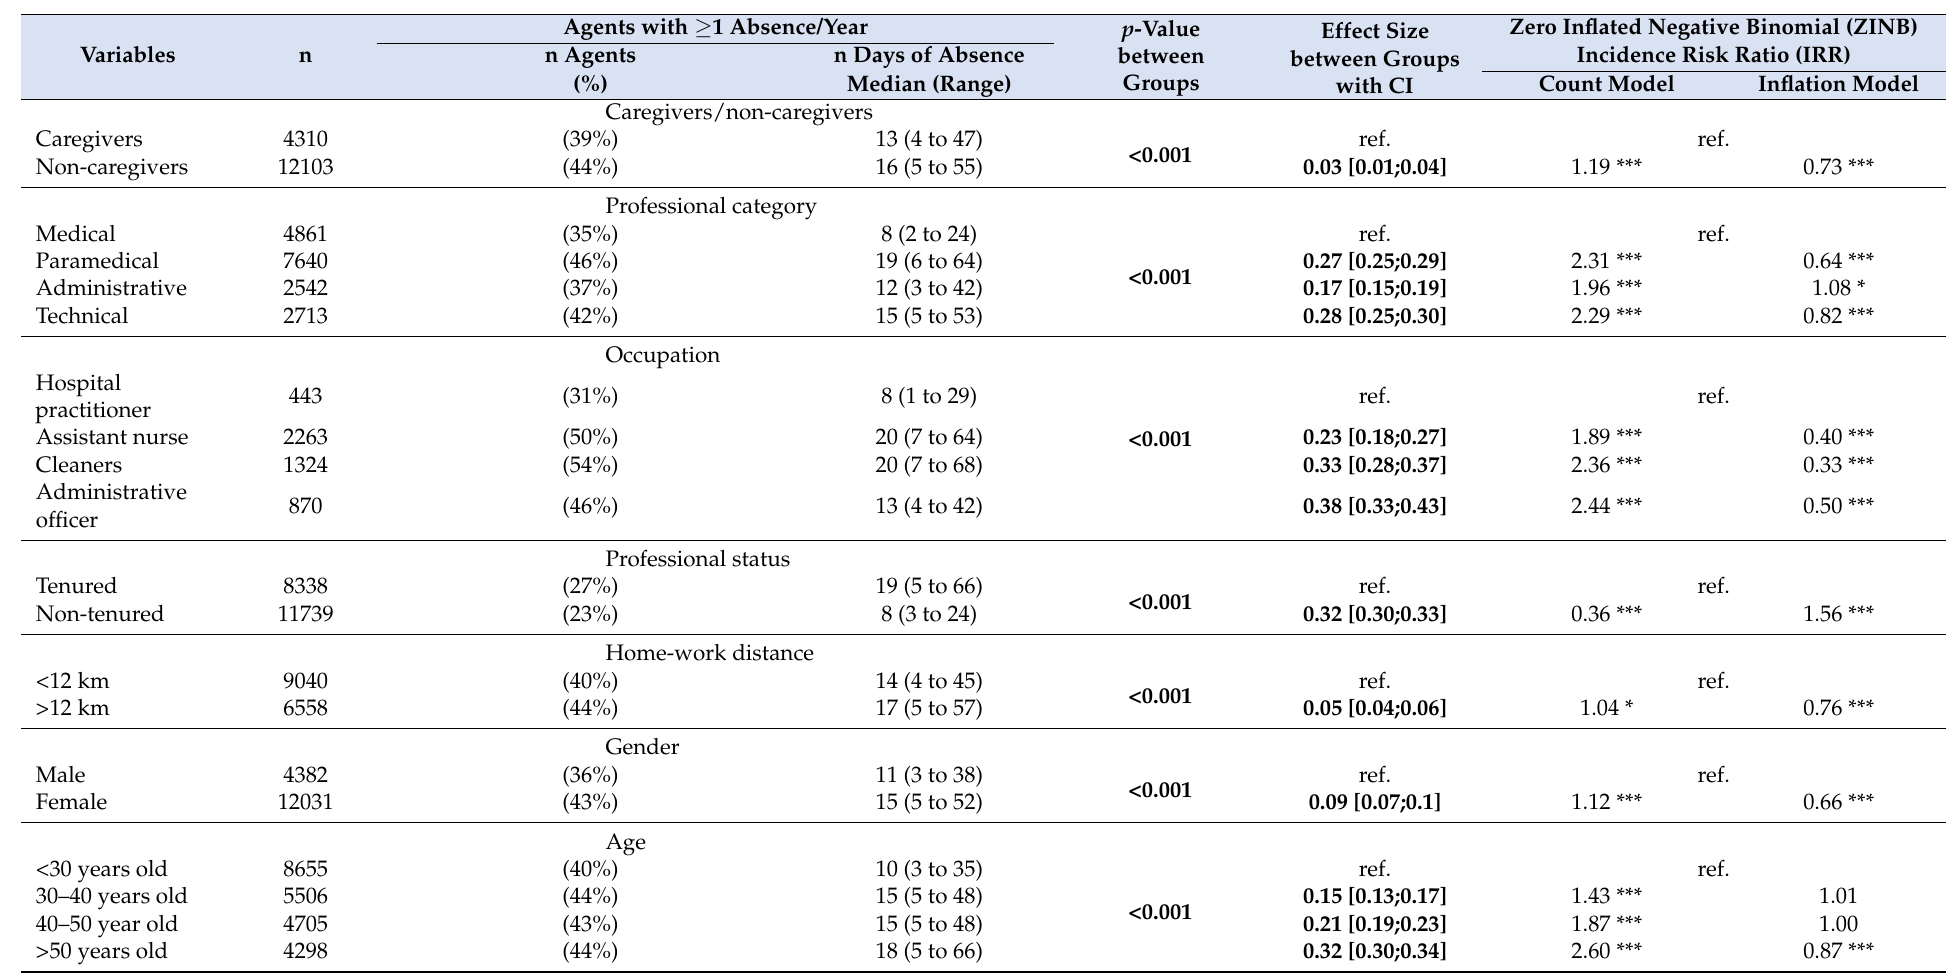
Table 1. Study of compressible absences by professional and sociodemographic